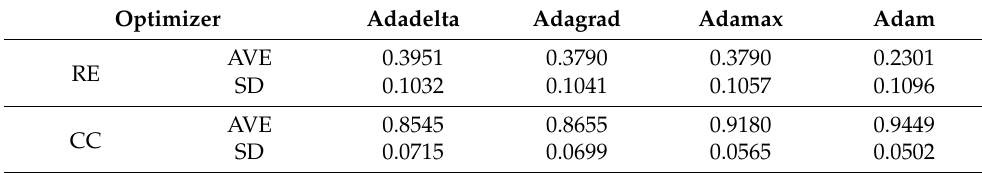
Figure 12. Models and their inversion results with different optimizers. Table 4. The RE and CC of all samples in the test set with different